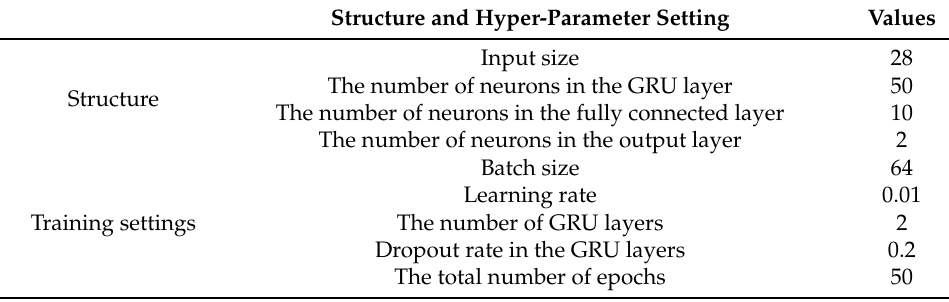
Table 2. Structure and hyper-parameter setup of the GRU